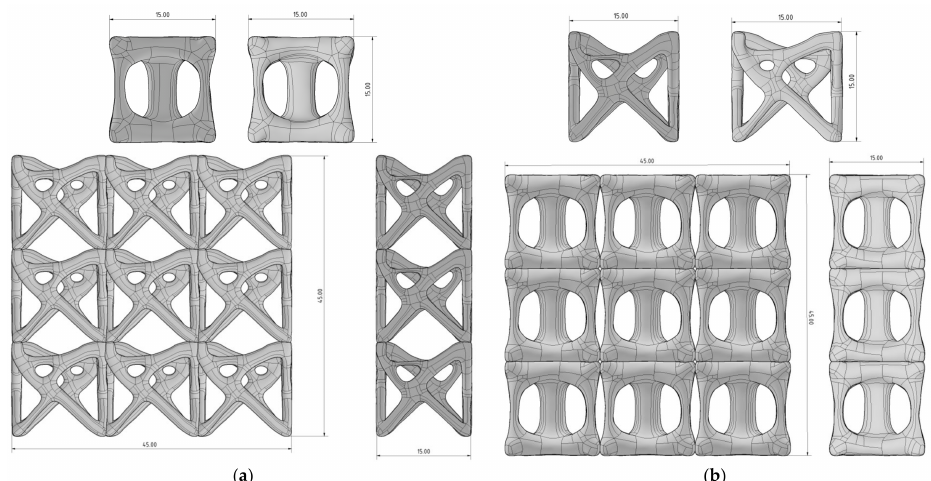
Figure 8. Outline dimensions of unit cells and lattice models for the compression test of ( a ) structure #1 with a volume fraction constraint = 0.4 and ( b ) structure #2 with a volume fraction constraint = 0.1.